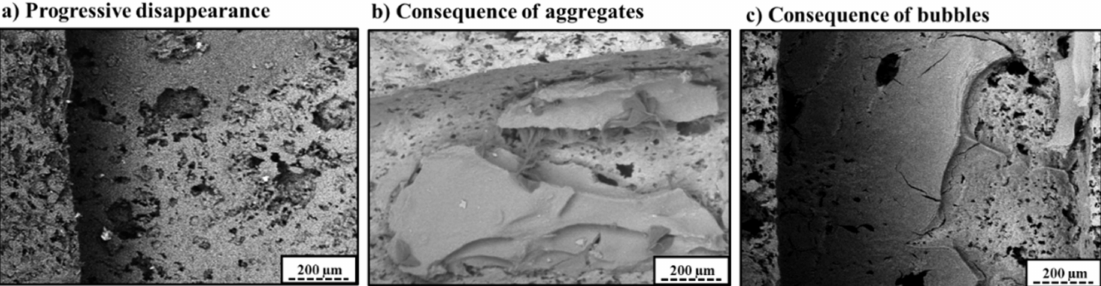
Figure 13. Illustrations of the three main type coating-free areas